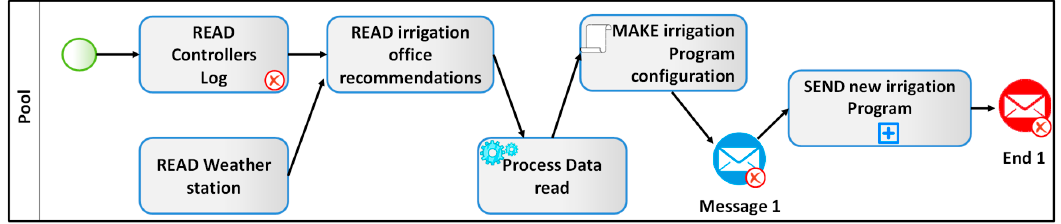
Figure 4. Diagram of business process management (BMP) process.